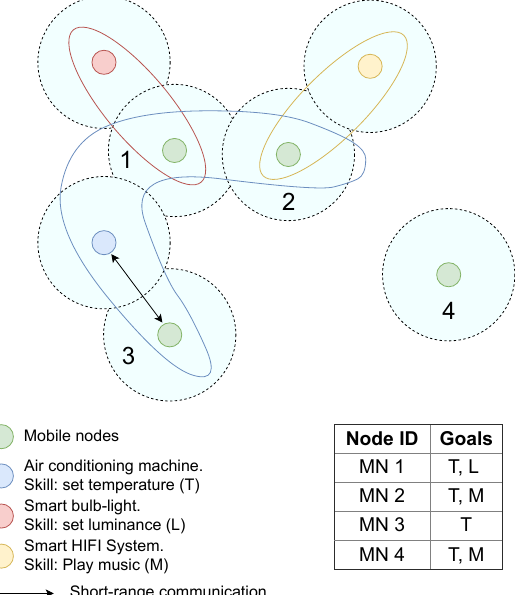
Figure 2. Example of three Opportunistic Context-Virtual Networks (OCVNs) in a seven-node